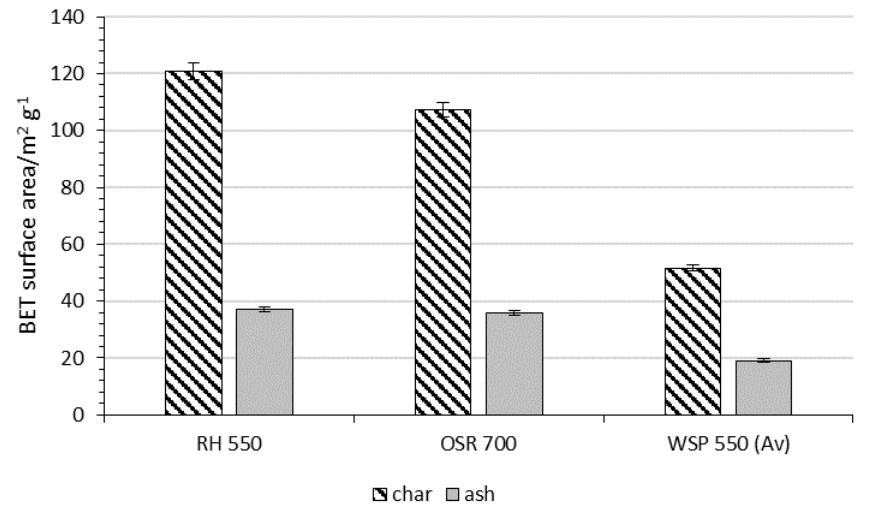
Figure 8. Comparison of BET surface area of biochar and ash from di ff erent feedstocks (rice husk (RH), oil seed rape (OSR) and wheat straw (WSP)). Isotherm obtained using N 2 at 77 K. Error bars calculated from three repeats of WSP 550 (denoted by (Av)); standard deviation ± 1.25 m 2 g − 1 , percentage error 2.42%.